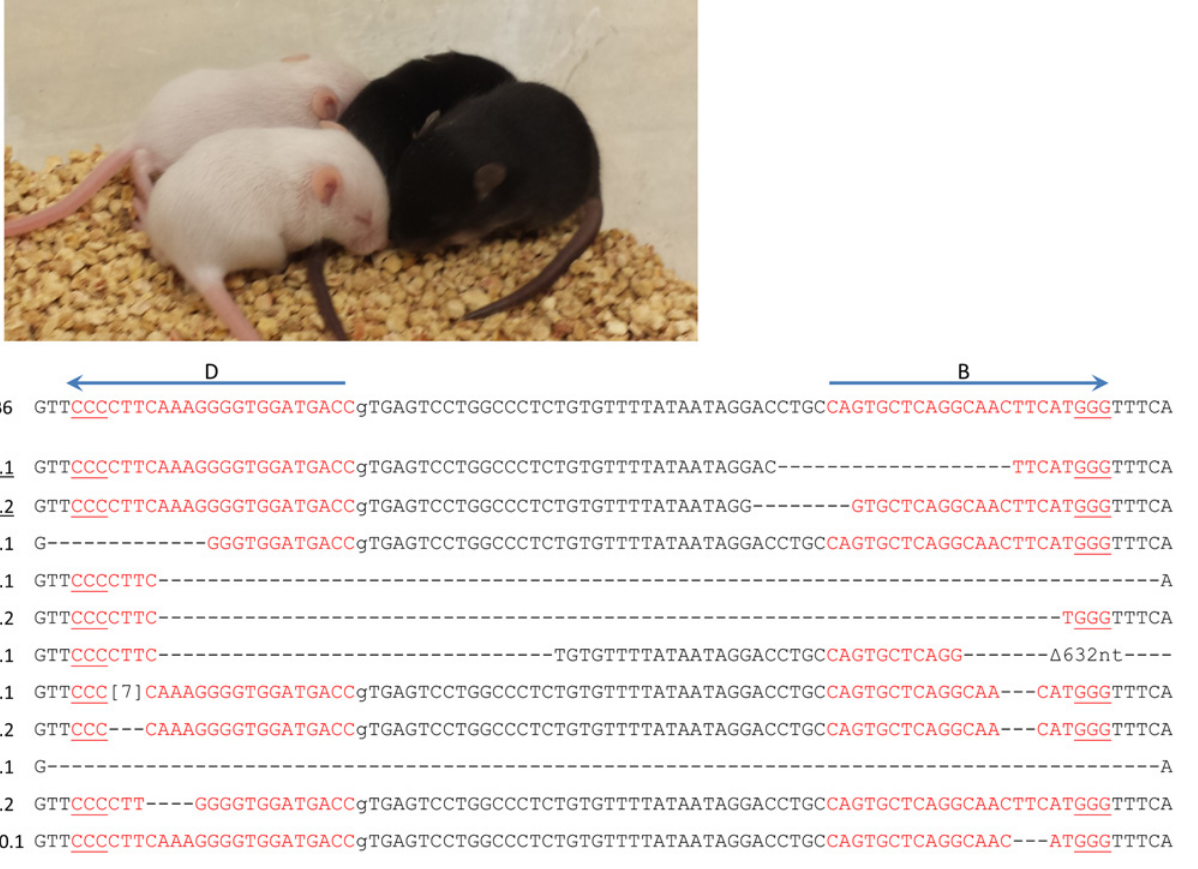
Figure 3. Paired sgRNAs result in gene disruption by phenotype and DNA sequencing. (a) Phenotypic results of guide B and D editing of B6xB6 fertilized eggs (Experiment 2) resulted in loss of black coat color in two of four pups photographed on day 14 after birth. The following mouse numbers and their phenotypes are shown: 2.3 (black), 2.4 (black), 2.5 (white), 2.6 (white). (b) Sequencing results of combined guide B and D editing are depicted. The B6 allele is indicated with the positions of guides B and D as in Fig. 1. Mice are numbered as in Fig. 2b. Sequencing results from unaltered Tyr alleles are not shown (2.4.2, 2.10.2). No PCR product was detected for allele 2.6.2; later it was confirmed to be a large 42 kb deletion (Fig. 8). Underlined alleles were from a D10A Cas9 injection. Deleted nt (-). Inserted nt in brackets.